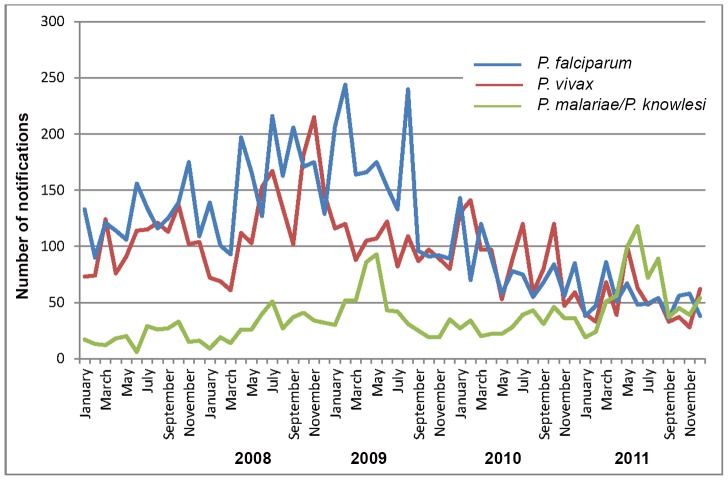
Monthly malaria notifications, 2007–2011.